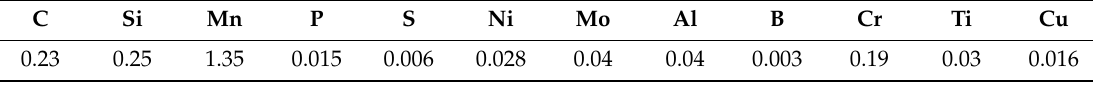
Table 1. The chemical composition of the studied boron steel sheet